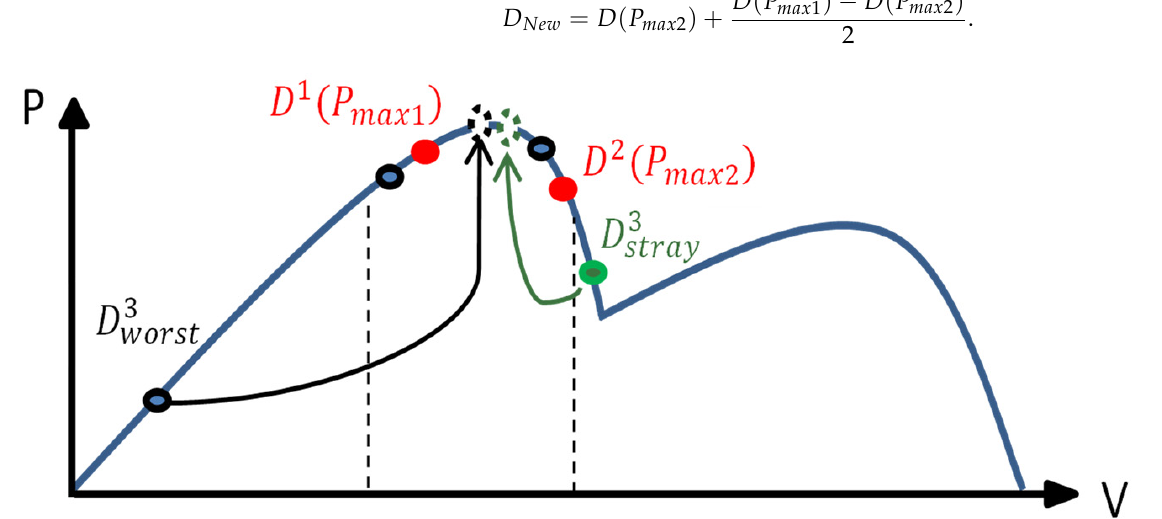
Figure 6. The new position of the weakened duty cycles towards the GMPP. The flowchart of the proposed technique can be simplified, as in Figure 7.